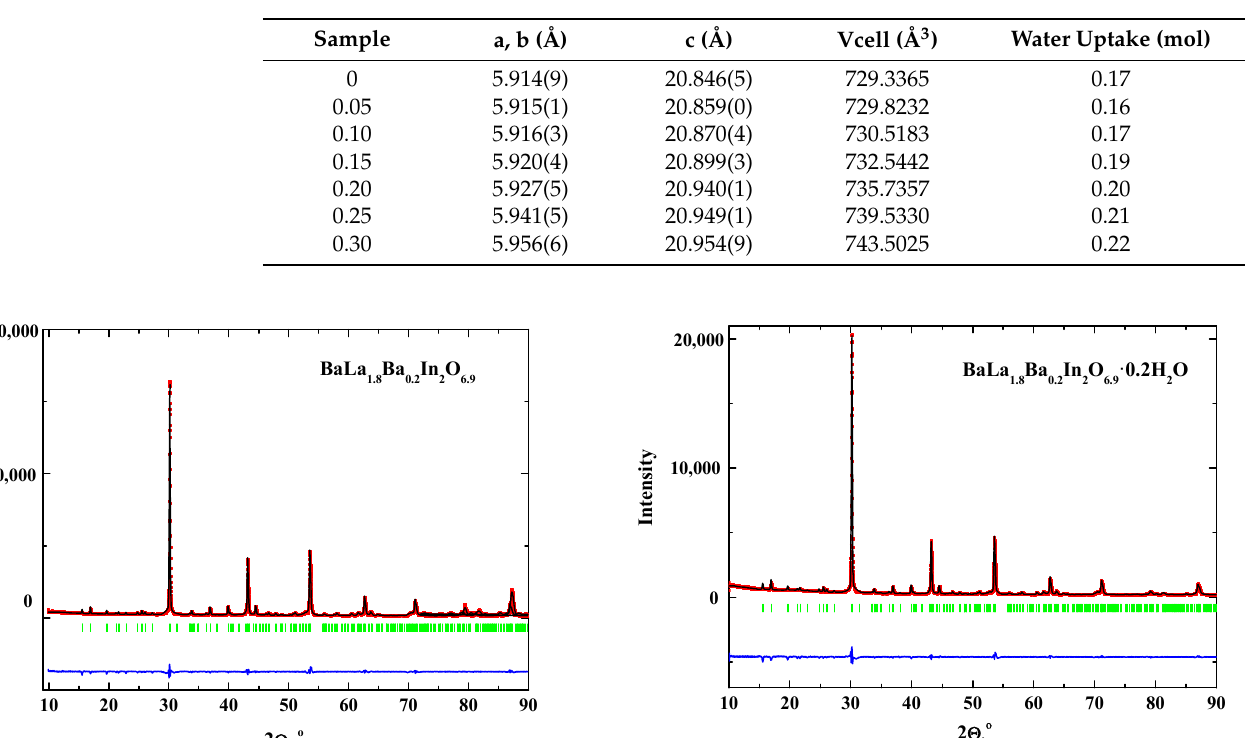
The possibility for water uptake was investigated by the thermogravimetry (TG) Table 1. Lattice parameters, unit cell volume, and water uptake for BaLa 2 − x Sr x In 2 O 7 − 0.5 x . Sample